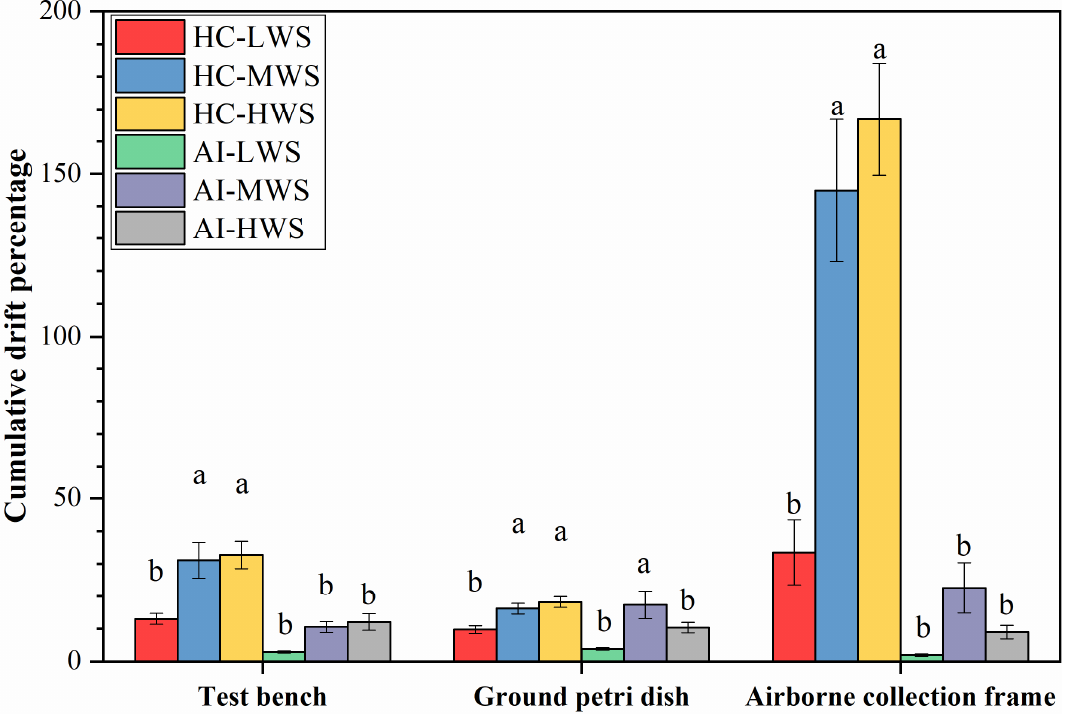
Figure 8. Cumulative drift percentage in mean ± standard error obtained from test bench, ground petri dish, and airborne collection frame with HC and AI nozzles at LWS, MWS, and HWS. Different letters above the bars represent significant differences among different configurations for each measuring method (Duncan test, α = 0.05). Table 4. Significance obtained from two-way ANOVAs for CDP B , CDP G , and CDP A , as affected by wind speed, nozzle type based on test bench, ground petri dish, and airborne drift collection frame.